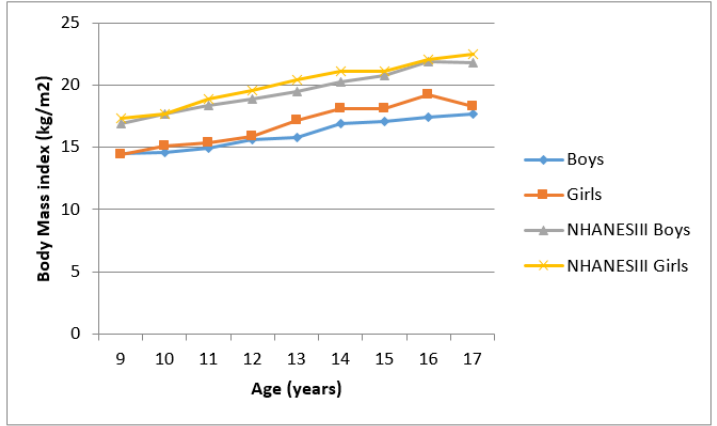
Figure 2. Mean body mass index of Ellisras children compared to the NHANES III reference population aged 9–17 years.